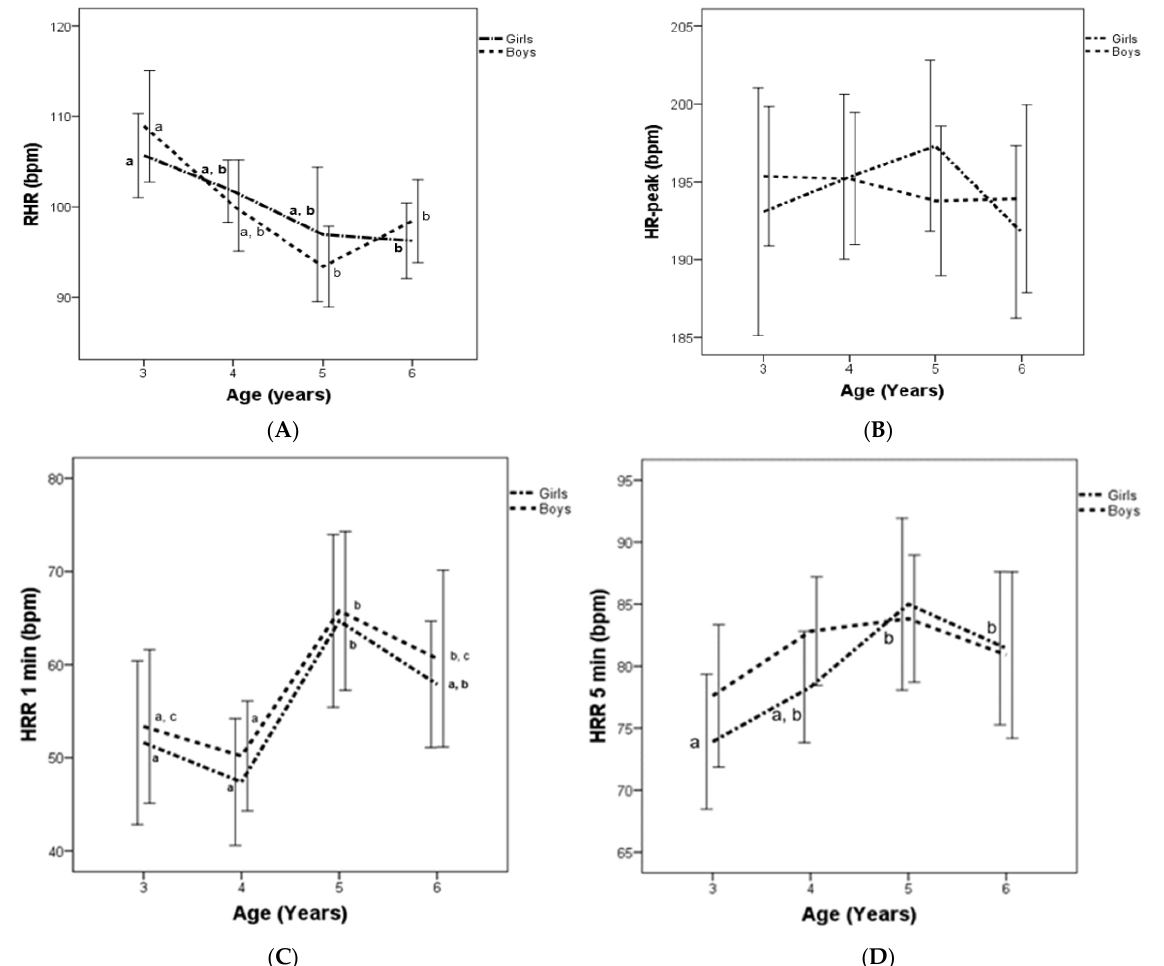
Figure 1. Resting heart rate (RHR) ( A ), HR peak ( B ), and heart rate recovery (HRR) at 1 min ( C ) and 5 min ( D ) for Spanish boys and girls, by age group. Subscript letters indicate significant intra-group differences ( p < 0.05).